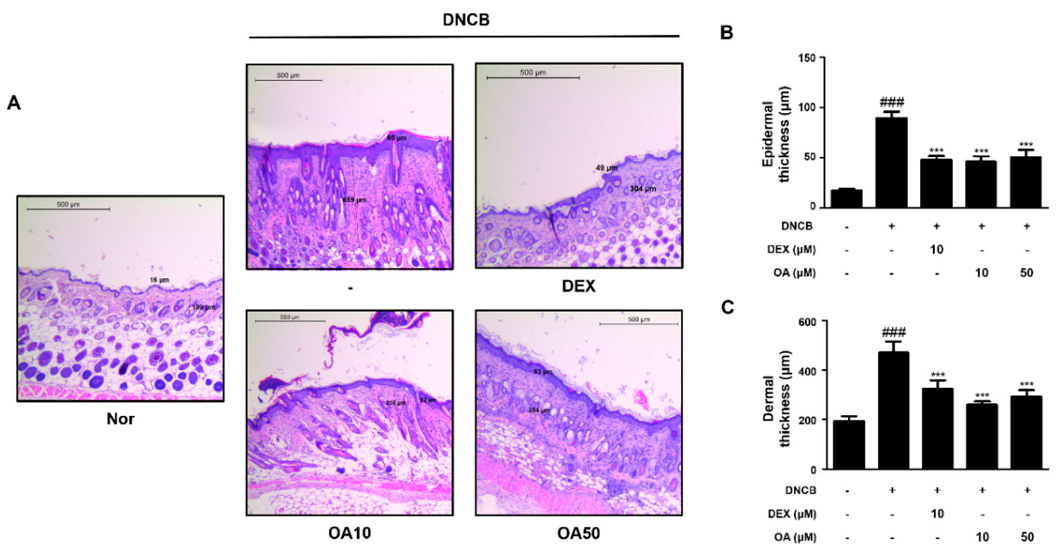
Figure 2. Effect of OA on epidermal and dermal thickness in DNCB-induced AD skin lesions. ( A ) H&E stained AD mouse skin lesions (scale bar = 500 μ m). ( B ) Determination of epidermal thickness and ( C ) dermal thickness. Epidermal and dermal thickness in H&E stained sections were measured under a microscope. The data shown represent mean ± S.D. ( n = 6) of three independent experiments. ### p < 0.001 vs. the control group; *** p < 0.001 vs. DNCB-treated group.